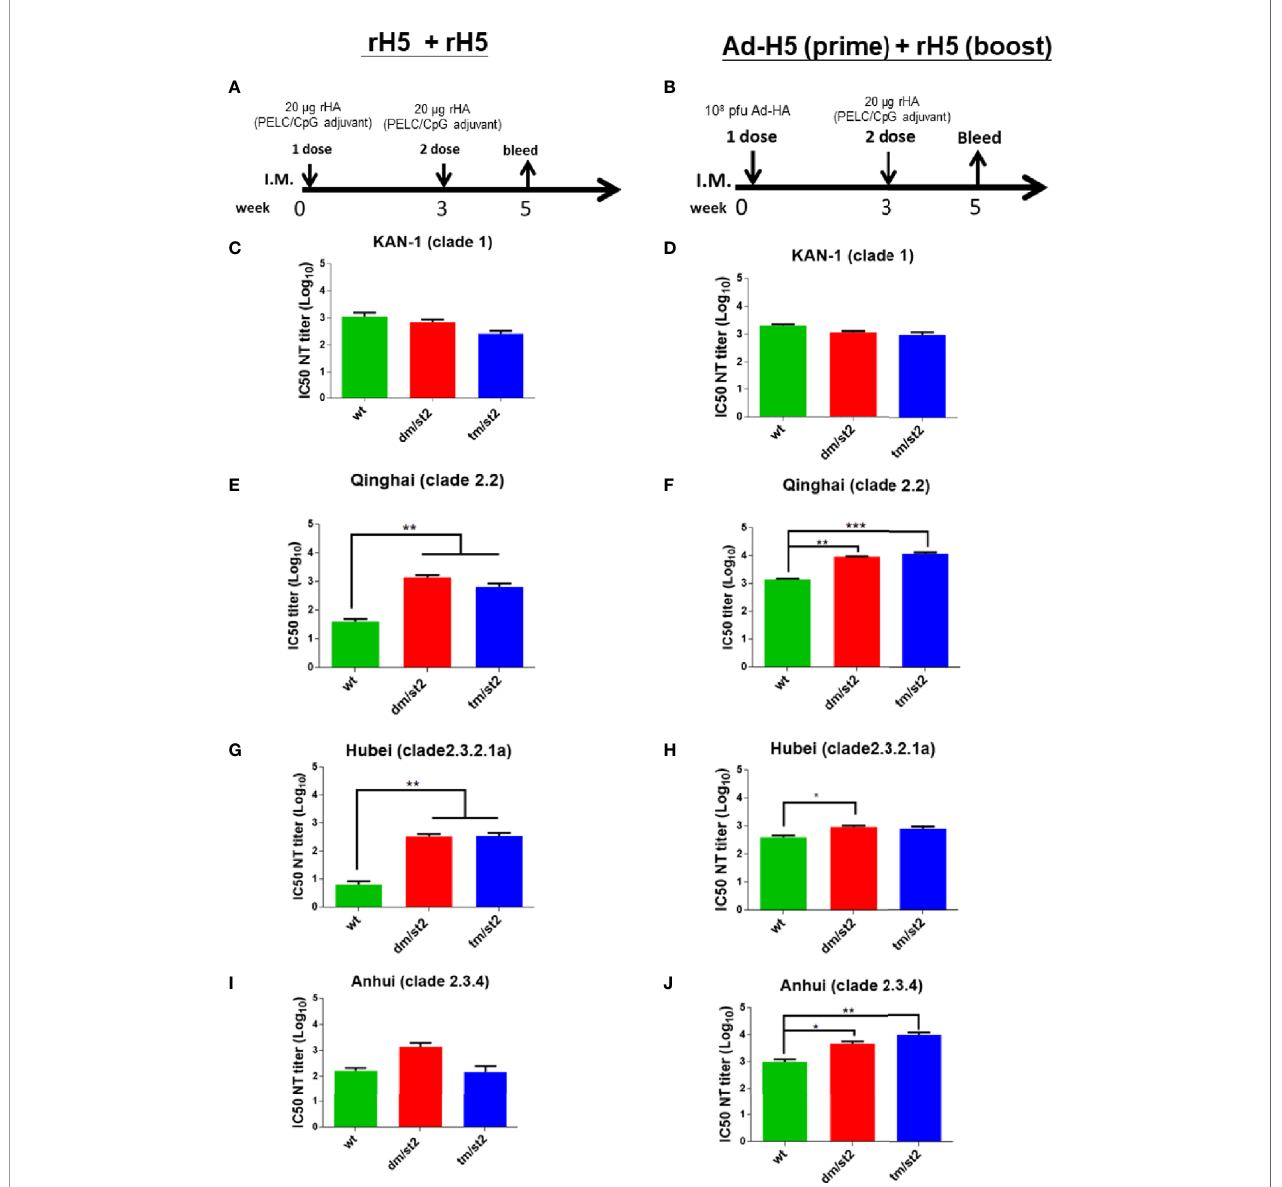
FIGURE 3 | Neutralizing antibody titers against the homologous and heterologous H5N1 strain elicited by immunizations with two-dose rH5 protein or adenovirus vector-prime + rH5 protein-boost regimen. Groups of BALB/c mice were immunized by (A) rH5 + rH5: two-dose rH5 proteins with PELC/CpG adjuvant and (B) Ad-H5 (prime) + rH5 (boost): fi rst-dose Ad-H5 and second dose rH5 with PELC/CpG adjuvant. Neutralizing antibody titers of IC50 values of rH5 + rH5 regimen against (C) KAN-1 (clade 1), (E) Qinhai (clade 2.2), (G) Hubei (clade 2.3.2.1a), and (I) Anhui (clades 2.3.4). IC50 values of Ad-H5 (prime) + rH5 (boost) regimen against (D) KAN-1 (clade 1), (F) Qinhai (clade 2.2), (H) Hubei (clade 2.3.2.1a), and (J) Anhui (2.3.4). Data were analyzed using one-way ANOVA. (*p < 0.05, **p < 0.01, and ***p <